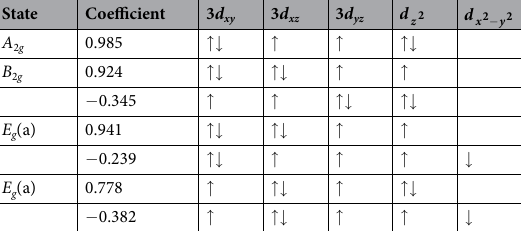
Table 1. The multi determinants calculated by SA-CASSCF for each electronic configurations. This table shows the occupation of d shell of each determinant and its coefficient. ↑ and ↓ means up spin and down spin respectively. Only the dominating determinants are listed up, whose coefficient’s absolute values are higher than 0.2.